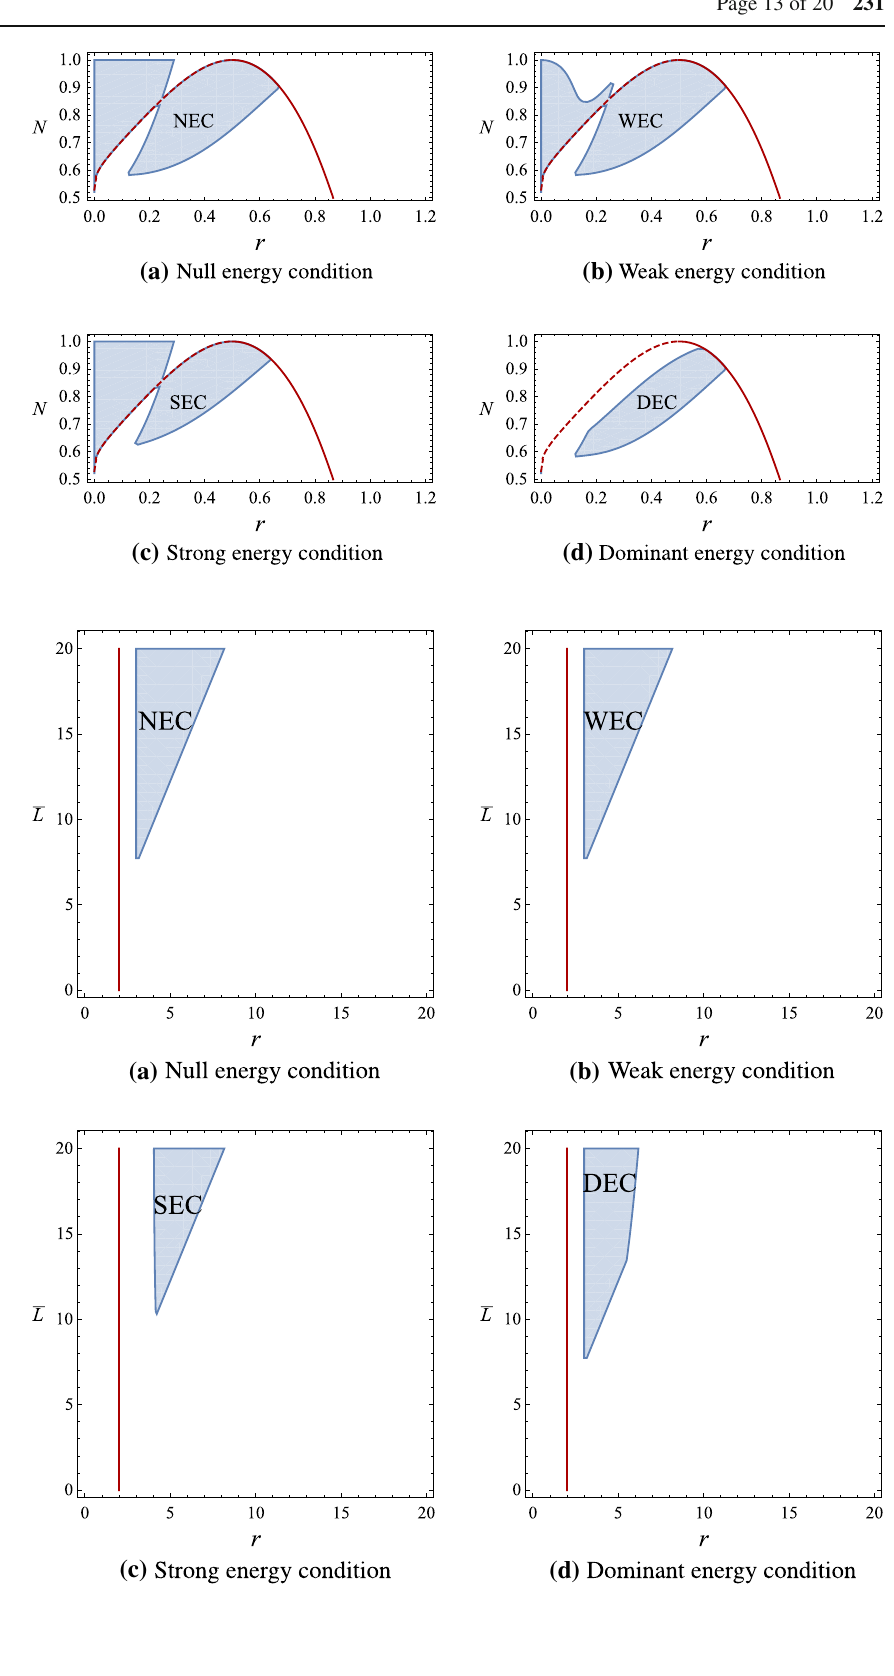
Fig. 9 The blue shadows show the valid domains of various energy conditions for the case of L = 1 / 2. The dotted red curves are inner horizons while the solid ones outer horizons in this case. The existence of horizons gives the constraint, 1 / 2 (cid:3) N (cid:3) 1, in this case